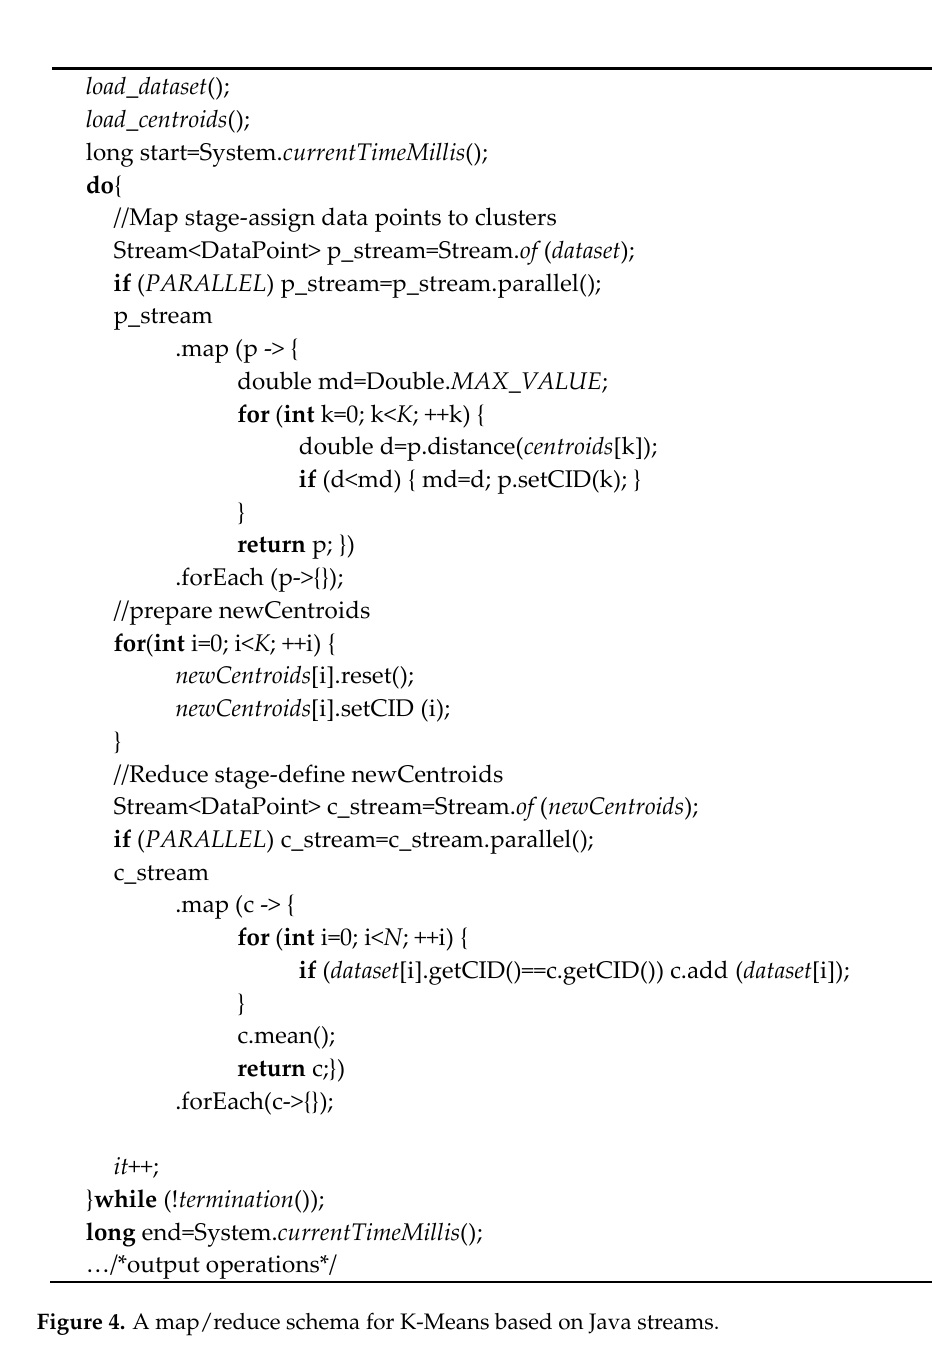
Figure 4. A map/reduce schema for K-Means based on Java streams.